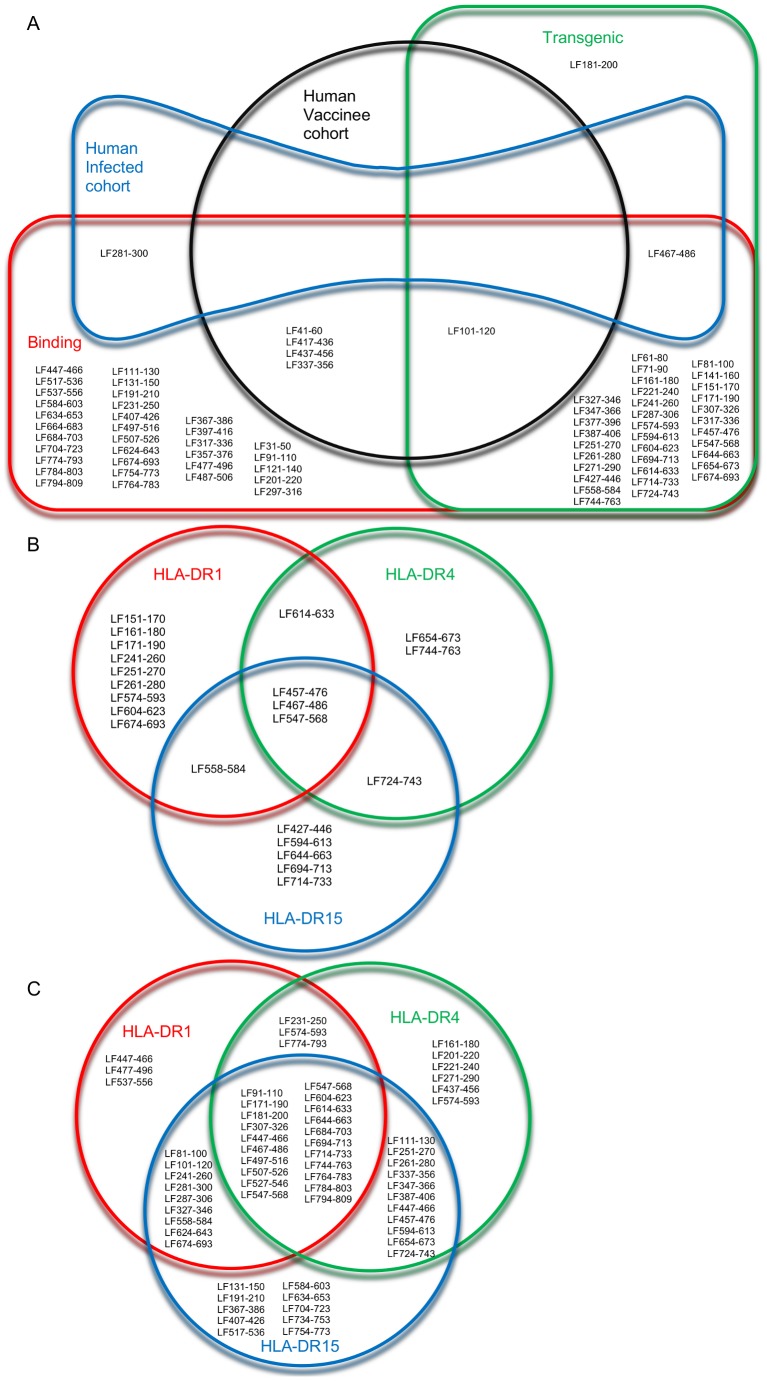
Overview of allele specific and promiscuous epitopes identified by binding affinity, and immunogenicity in HLA transgenic mice and human subjects.The overlapping relationships of the epitopes identified in the HLA transgenic responses, HLA-DR binding affinity studies, and in cohorts of vaccinated and infected humans, were demonstrated in a Euler diagram (A). The HLA-DR restricted epitopes identified in (B) HLA transgenic mice and (C) HLA binding affinity studies were visualised as Venn diagrams, to show allele specific and promiscuous epitopes.